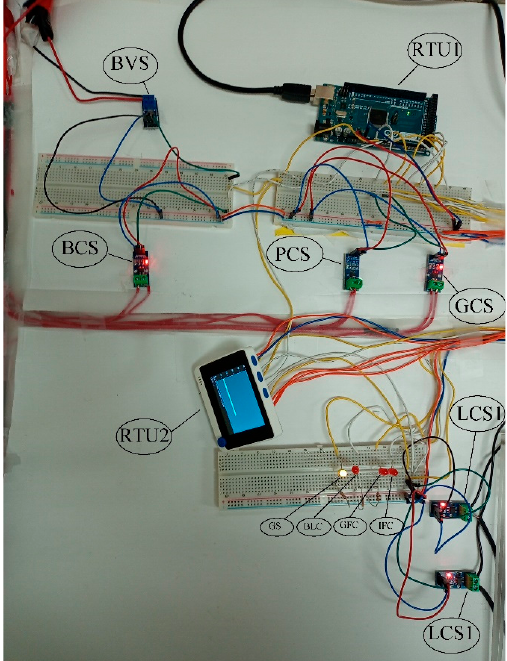
Figure 9. Hardware implementation of proposed system.